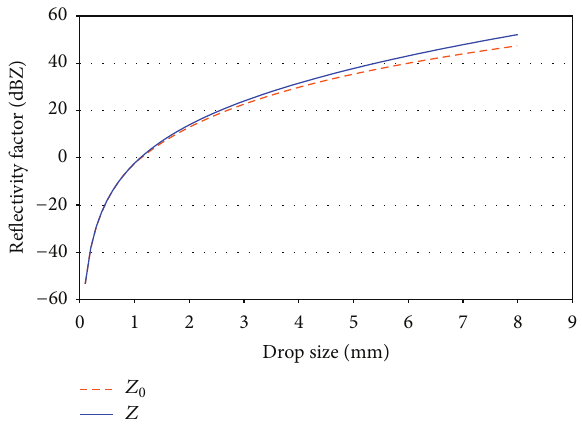
Figure 6: Reflectivity factors calculated with the sampling area uncorrected ( 𝑍 0 ) and corrected ( 𝑍 ).